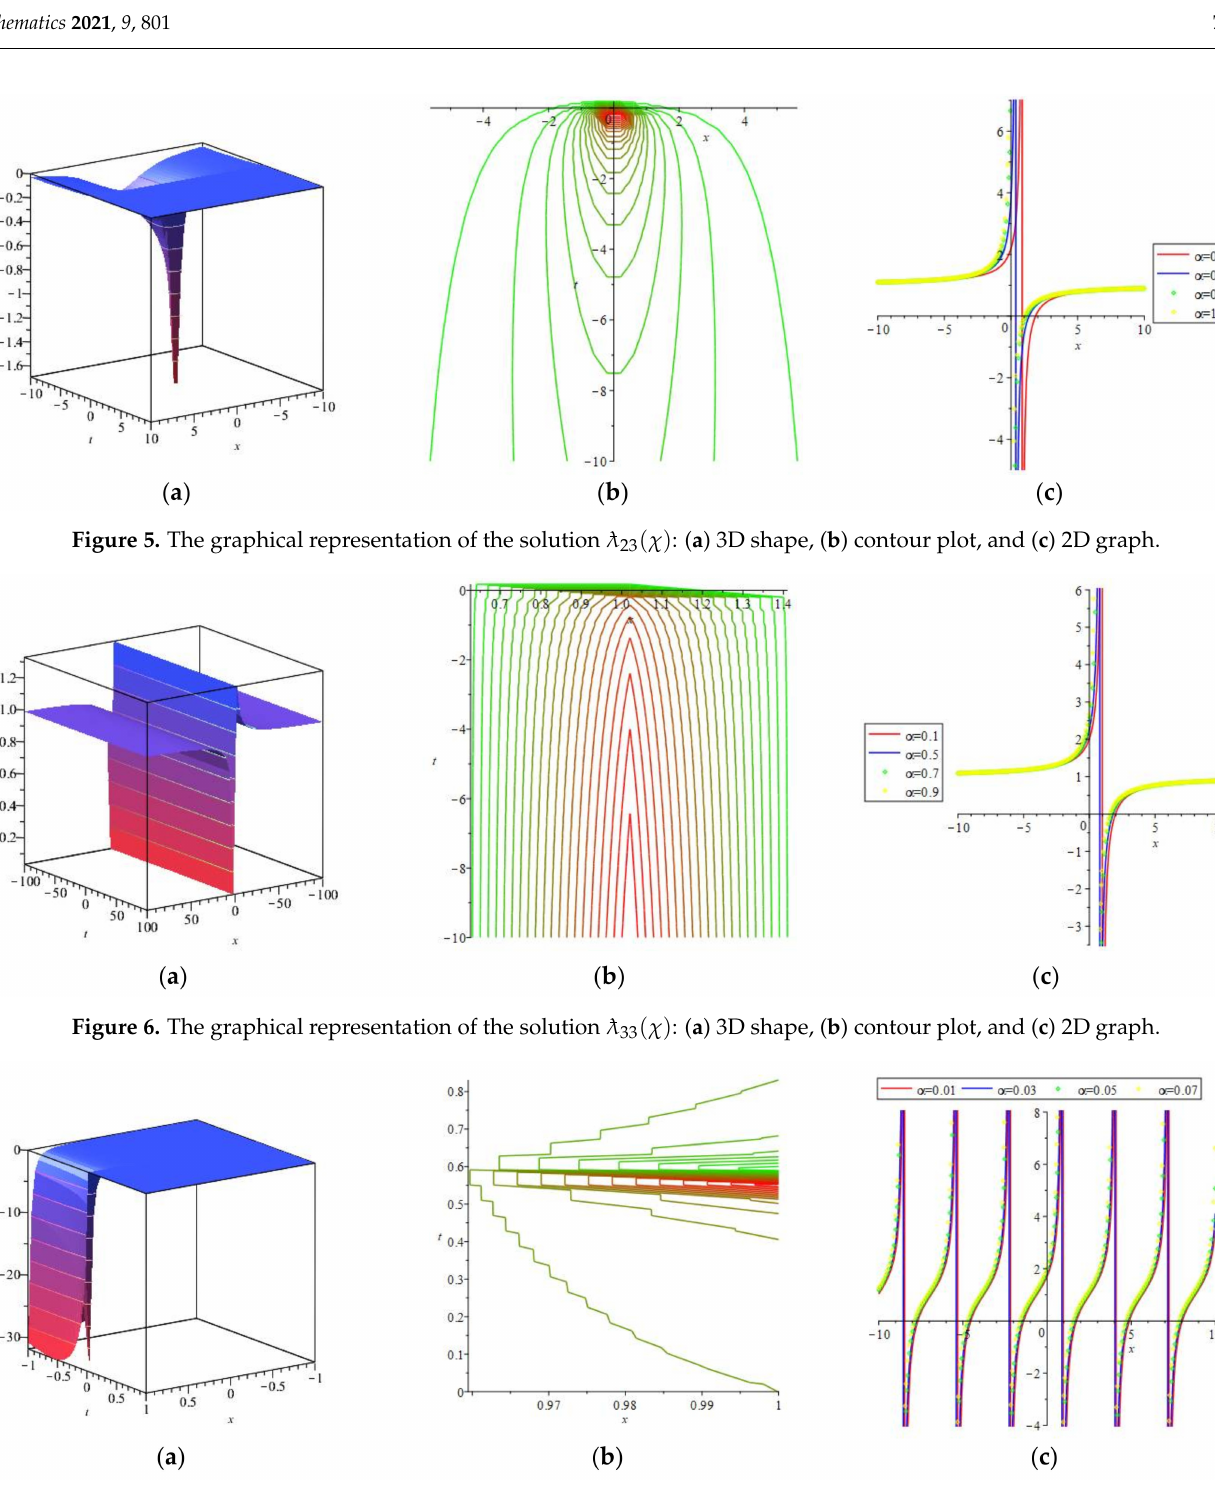
Figure 7. The graphical representation of the solution λ 14 ( χ ) : ( a ) 3D shape, ( b ) contour plot, and ( c ) 2D